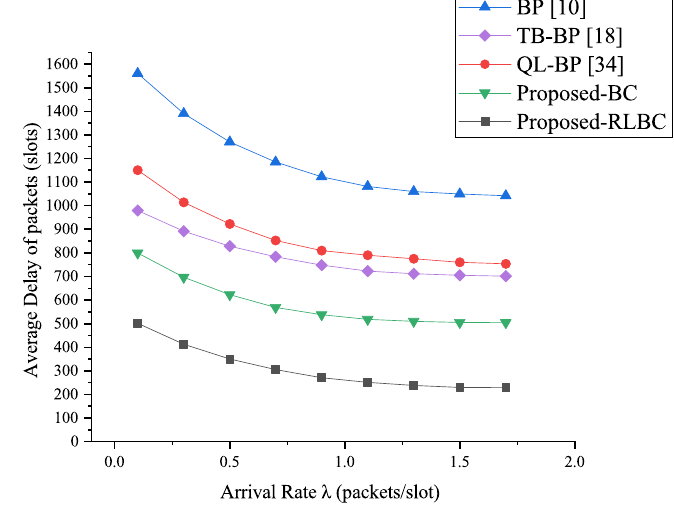
Figure 7. Average delay of packets with 50% malicious